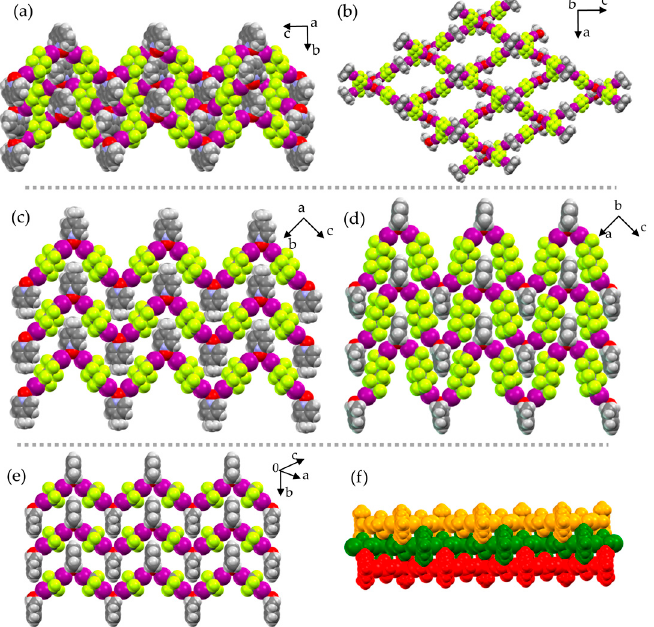
Figure 4. Interwoven by C − H···F interactions, the 1-D undulated XB polymeric chains in 2•DI4 ( a